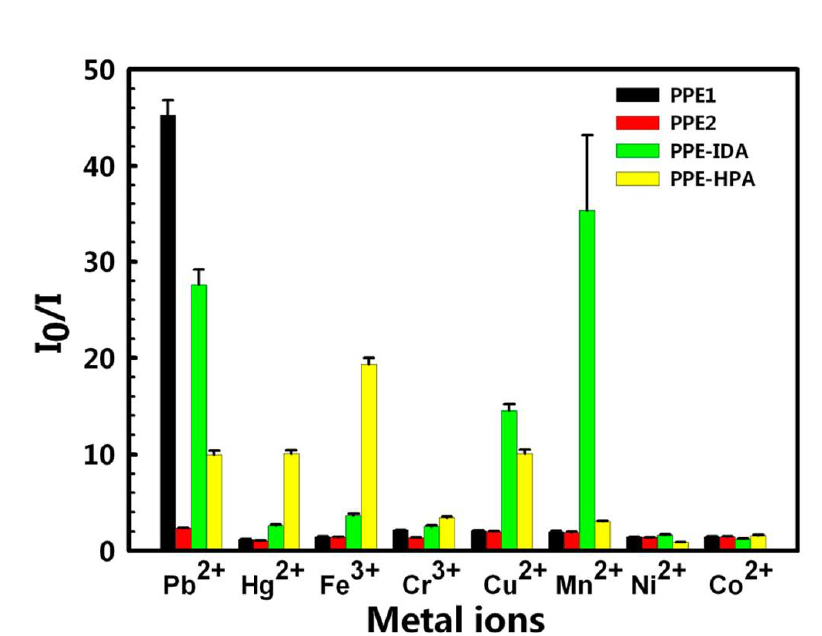
Figure 14. ( a ) Structures of the four conjugated polyelectrolytes, PPE1, PPE2, PPE − IDA, and PPE − HPA, ( b ) response patterns constructed based on fluorescence quenching of the four polymers by eight metal ions at 5 μM each. The response patterns were generated from the ratios of the polymers’ initial to final emission intensities. Error bars represent the standard deviations of six replicates for each PPE − metal ion pair. Polymers are PPE1, PPE2, PPE − IDA, and PPE − HPA, and metal ions are Pb 2+ , Hg 2+ , Fe 3+ , Cr 3+ , Cu 2+ , Mn 2+ , Ni 2+ , and Co 2+ . Adapted with permission from reference [117]. Copyright 2015, American Chemical Society.